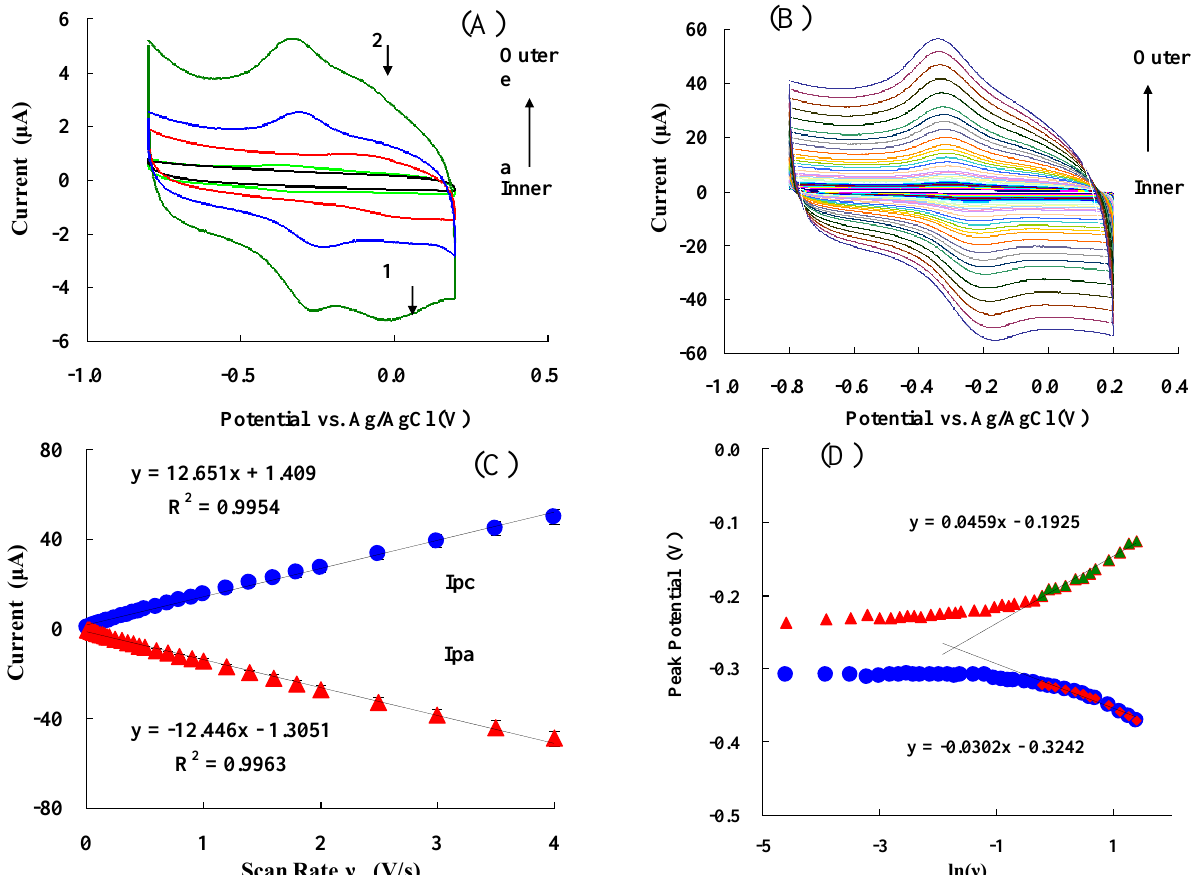
Figure 2. ( A ) CVs of different modified electrodes (from inner to outer): (a) Bare GC electrode; (b)NF/Hb/GC; (c) NF/FMWCNTs/Cys/AuNPs/GC; (d) NF/Hb/FMWCNTs/GC; (e) NF/Hb/FMWCNTs/Cys/AuNPs/GC. The experiments were carried out in 0.05 M PBS (pH7.0) at a scan rate of 0.05 V/s. ( B ) CVs of NF/Hb/FMWCNTs/Cys/AuNPs/GC electrode in 0.05 M PBS (pH 7.0) at various scan rates (from inner to outer): 0.02, 0.04, 0.06, 0.08, 0.1, 0.12, 0.14, 0.16, 0.18… 4 V/s, respectively; ( C ) Plot of peck current I vs. p scan rate ν; ( D ) Plot of peak potential E vs. ln p